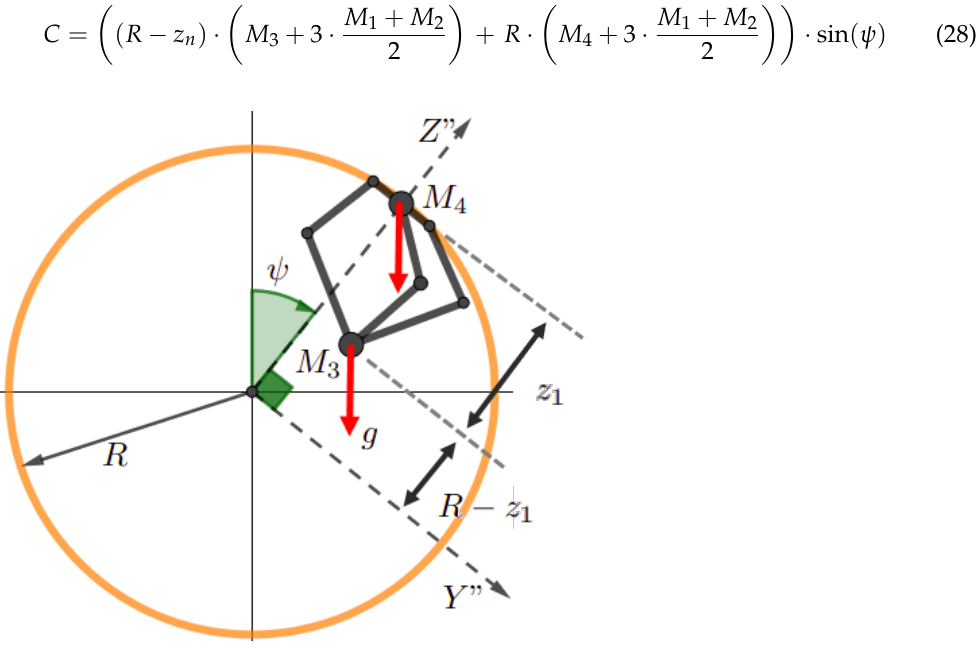
Figure 23. The substantial forces to generate T 4 g